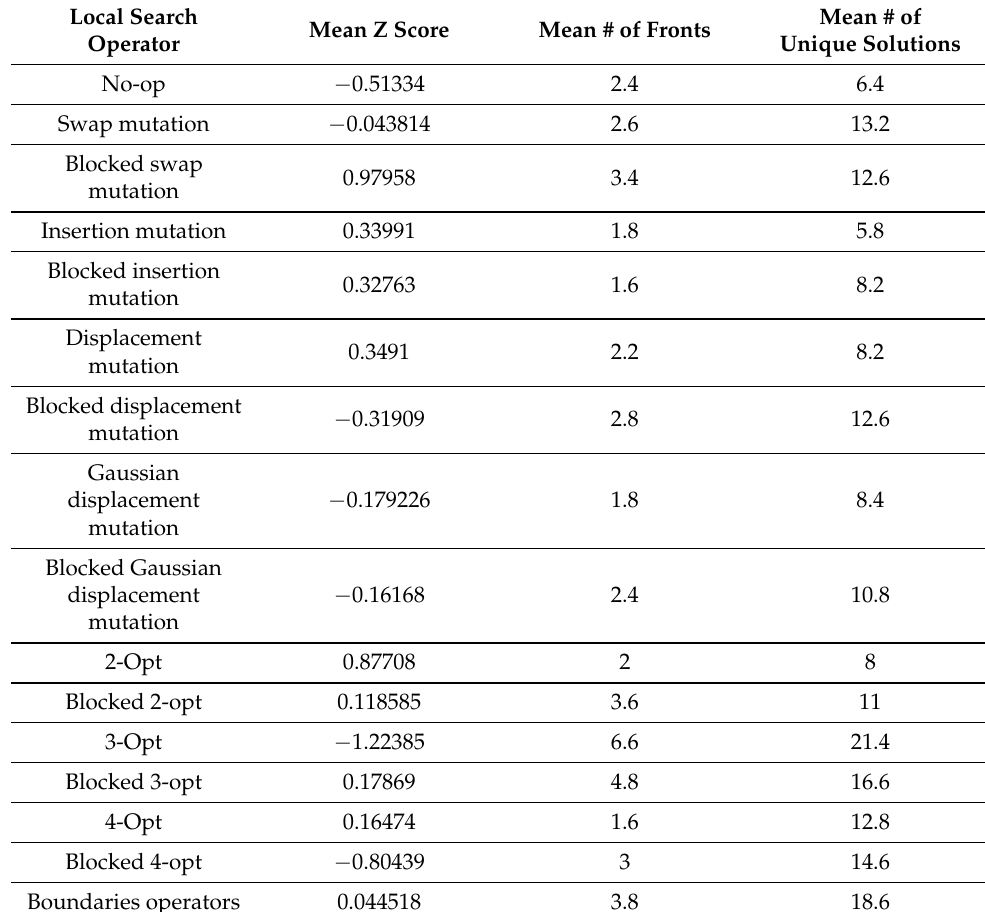
Table 7. Local search operators summary